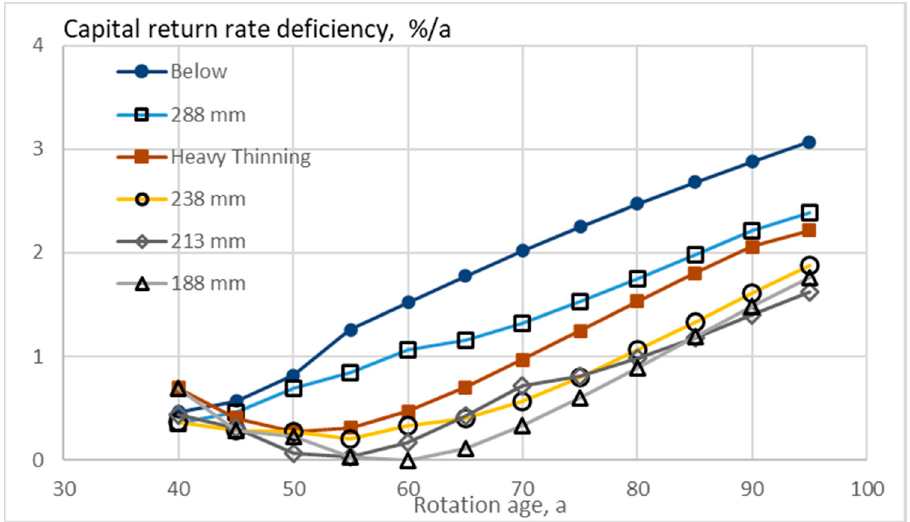
Figure 10. The deficiency of the expected value of capital return rate, in comparison to maximum value available according to Equation (7) and Figure 3. The deficiency is plotted for six different treatment schedules and any rotation age.